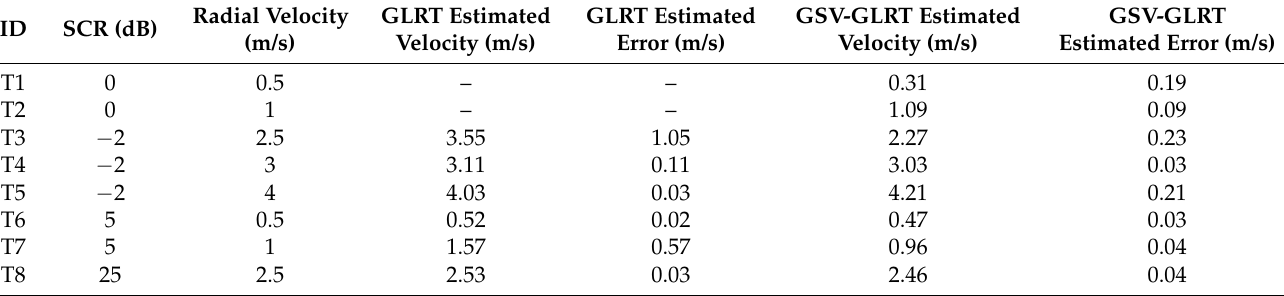
Figure 7. Scene and detection results. Table 2. Target Parameters and Estimated